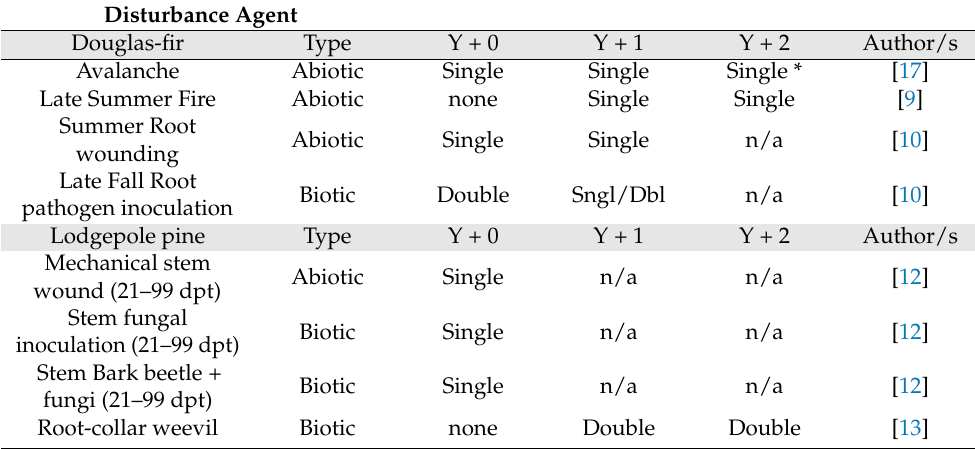
Table 1. A summary of studies documenting traumatic resin duct formation in response to abiotic or biotic agents or a combination (comb.) affecting mature Douglas-fir and mature lodgepole pine in North America. * Repeated until Y + 6; dpt = days post